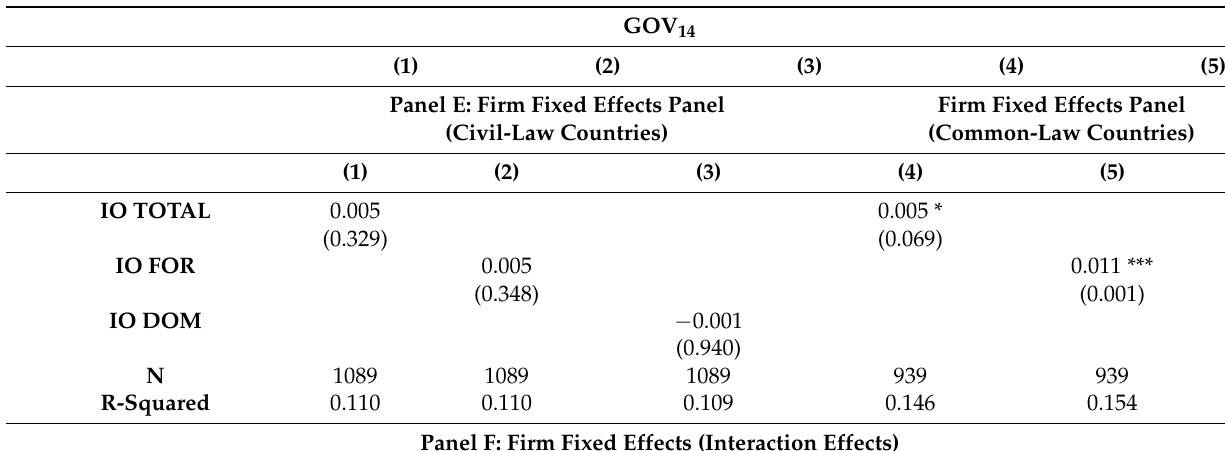
Panel F: Firm Fixed Effects (Interaction